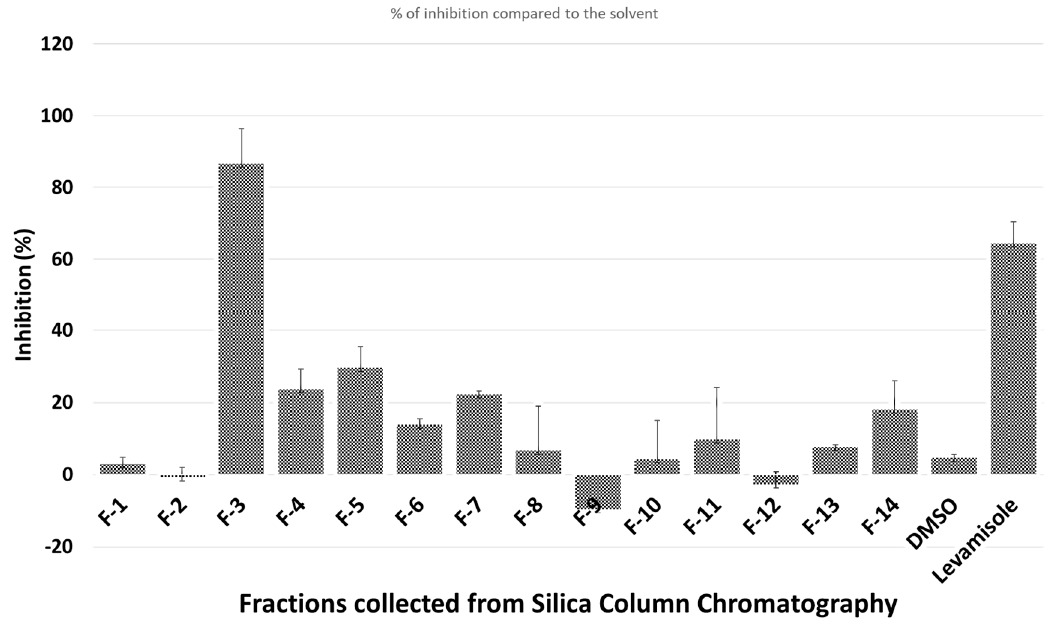
Figure 1. Nematicidal effects (activity based on movement of Caenorhabditis (C.) elegans detected by infrared microbeams) of different fractions collected from silica gel column.